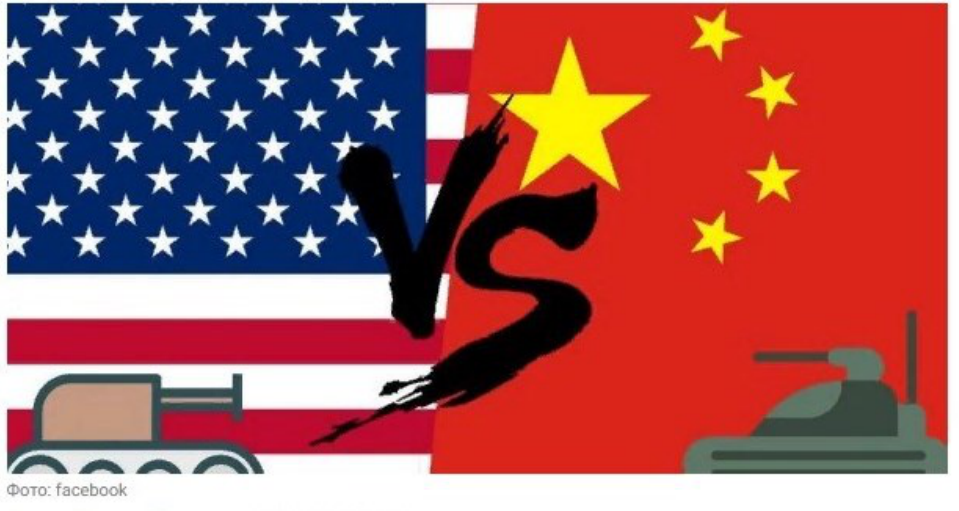
Fig. 2 – A multimodal